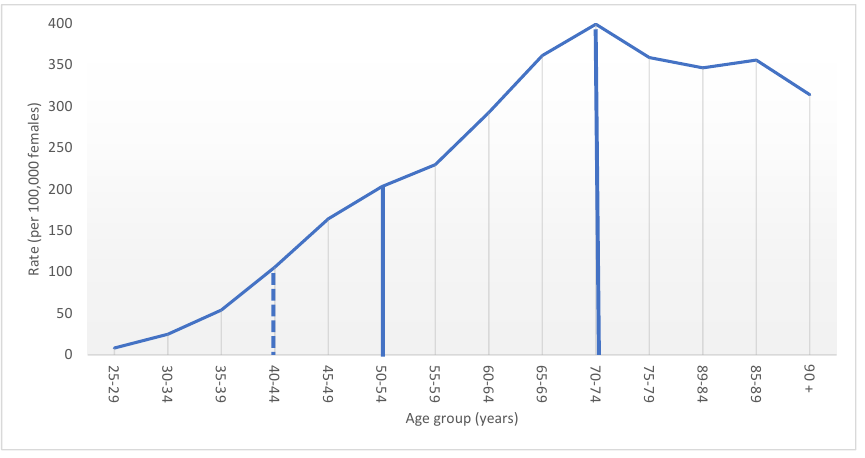
Figure 1. Age–specific female breast cancer incidence rate, by five–year age group, Canada excluding Quebec, 2010 to 2017 period. Note: Quebec is excluded because cases diagnosed in Quebec from 2011 onward had not been submitted to the Canadian Cancer Registry. Solid lines display current ages included in screening; dashed line indicates the age threshold where screening is being explored. Source: Canadian Cancer Registry (1992 to 2018) at Statistics Canada [42].